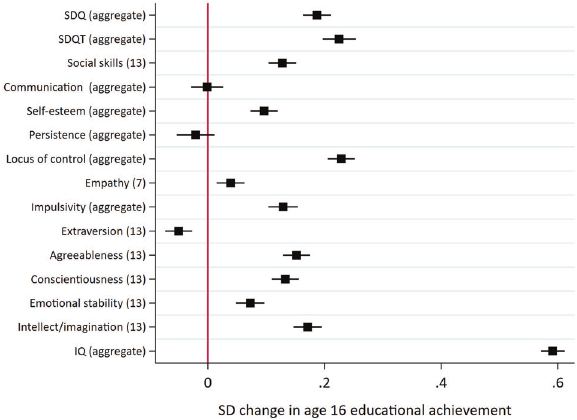
Fig. 4 Associations between aggregate skills and educational achievement at age 16. All skills and educational achievement were standardised to have mean zero and standard deviation one. Models for noncognitive skills include sex, month of birth and IQ at age 8 as controls. Models for IQ include sex and month of birth as controls. Educational achievement measured as exam point score at age 16. Age (years) in parentheses. SDQ: parent reported strengths and dif fi culties questionnaire; SDQT: teacher reported strengths and dif fi culties